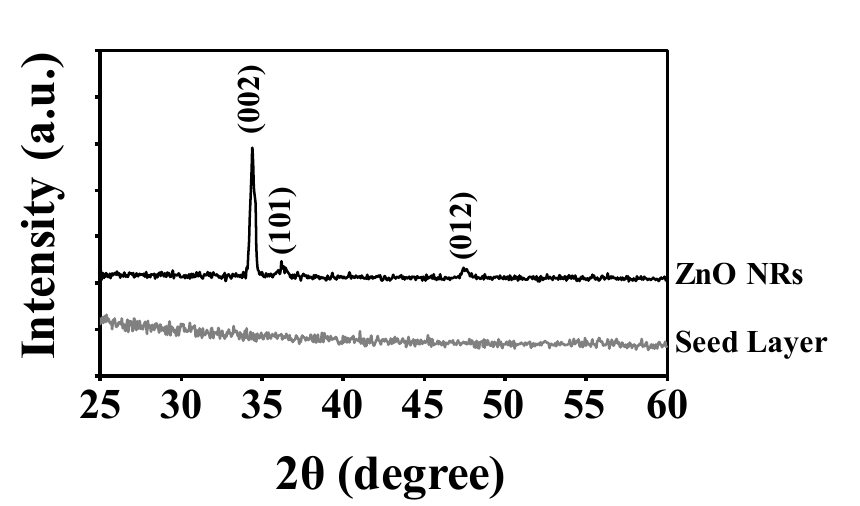
Figure 3. X-ray di ff raction (XRD) patterns of ZnO NRs and ZnO seed Figure 3. X-ray diffraction (XRD) patterns of ZnO NRs and ZnO seed layer.